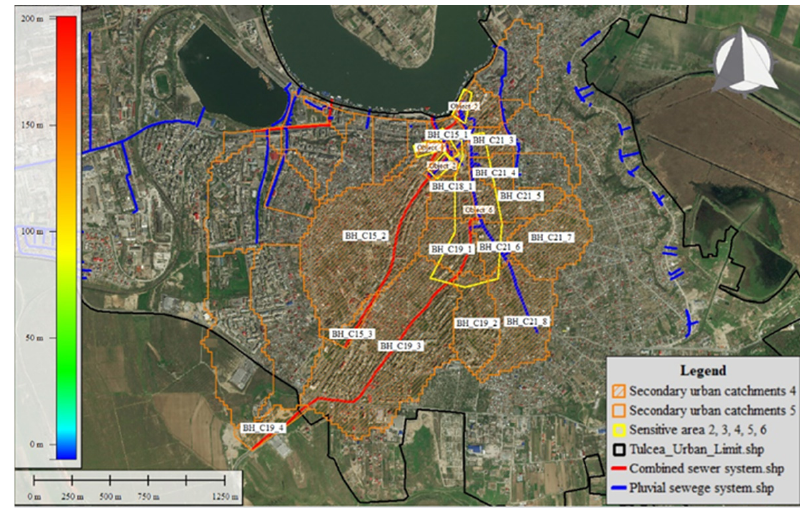
Figure 16. Sub-basins located in the area of Objects 2, 3, 4, 5, and 6.